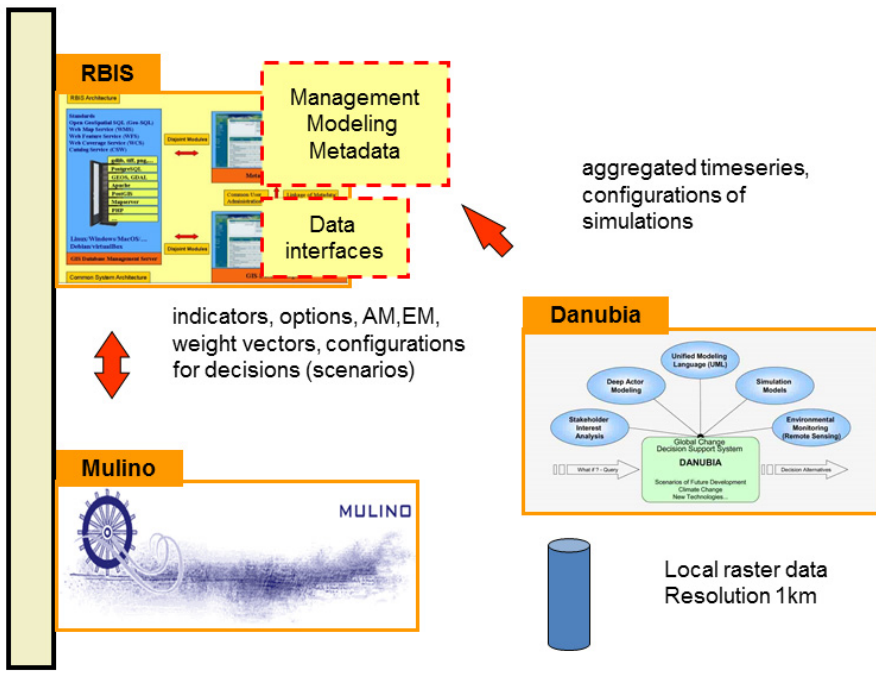
Figure 2. Implemented interaction structure between external applications.